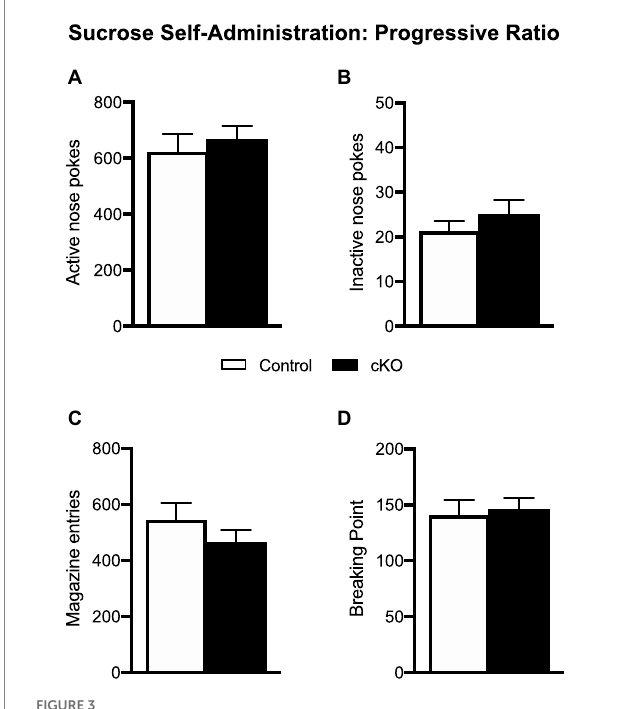
FIGURE 3 Active (A) and inactive pokes (B) , magazine entries (C) and breaking point (D) of control (white bars) and cKO (black bars) mice during the one-hour progressive ratio session. Data are expressed as mean ±